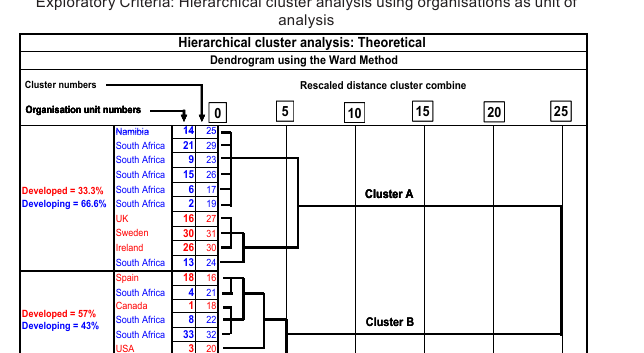
FIGURE 3 Exploratory Criteria: Hierarchical cluster analysis using organisations as unit of Hierarchical cluster analysis: Theoretical Dendrogram using the Ward Method